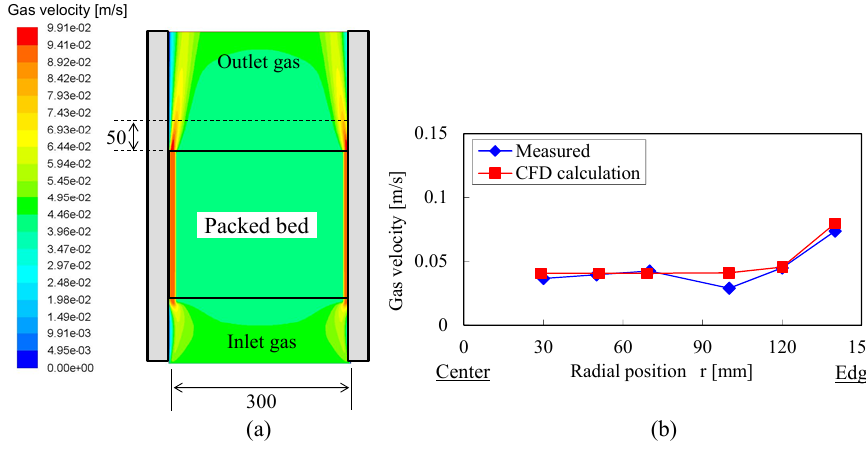
Figure 8. Results of laboratory-scale CFD simulation: ( a ) color contours of gas velocity distribution; and ( b ) radial gas velocity distribution obtained by experimental measurements and CFD simulation.